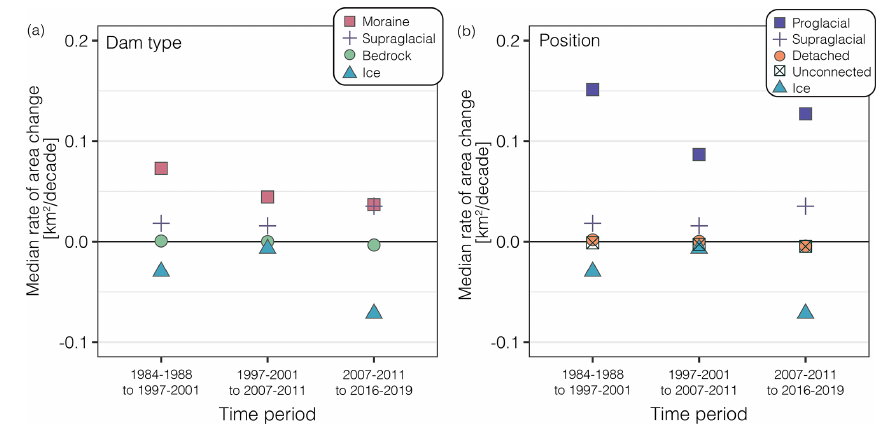
Figure 11. Median rate of area change between each time step, categorized by dam type (a) and topological position (b)